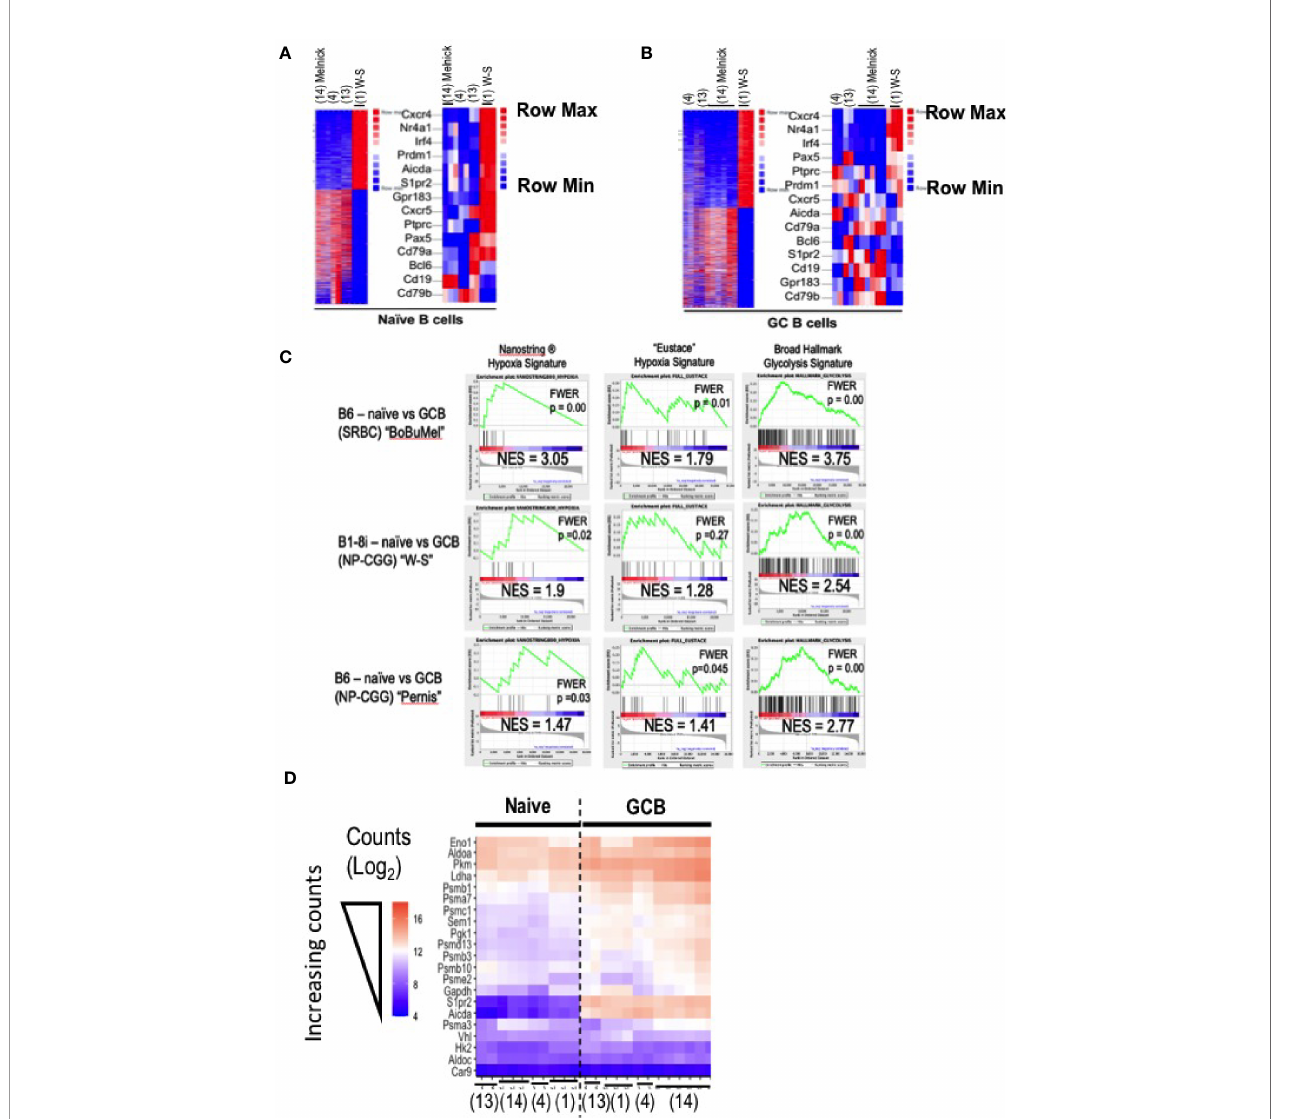
FIGURE 2 | Comparisons of condition-dependent differential gene expression. As in Figure 1 , GEO data deposits were downloaded for the papers cited as (1), “ W- S ” (17);, “ Bu ” (4);, “ Bo ” (18); “ Mel ” and processed by trimming, alignment, generation of normalized counts (FPKM), and quanti fi cation of differential expression using each of two independent pipelines (i.e., both bespoke and Basepair Technologies ’ ). (A, B) Heat maps generated in the Basepair Technologies platform and derived from differential expression analyses comparing the groups “ SRBC-immunized B6 mice ” versus the BALB/c B1-8i, Vk -/- system are shown for (A) naïve and (B) GC B cells. In each panel, all differentially expressed genes (16% and 14% of totals, respectively, i.e., 3214/22,843 and 3461/21,327 genes differentially expressed >2- fold with p-adjusted < 0.05) are displayed. To the right, a subset of B lineage-speci fi c or other genes functionally relevant in GC biology are shown. In these heat maps, entries that are dark red are upregulated and those that are blue are downregulated. Since the rows (genes) are Z-Score scaled, the maps report differences in expression of single genes across the samples. (C) Gene Set Enrichment Analyses (GSEA) were performed using the Broad algorithm as detailed in the Methods log. Analyses were performed both with data derived by the bespoke pipeline (shown here) and with the expression data exported from the Basepair pipeline, which yielded congruent results to those shown here. Inset values show the normalized enrichment score (NES) and p value after compensation for multiple comparisons (FWER), as indicated. Each panel displays results for a separate analysis in which ranked differential expression data were processed using the Broad Institute ’ s GSEA software. The three columns represent outputs obtained using the indicated gene signatures: Hypoxia Signature as established by Nanostring Technologies ® , the hypoxia gene signature of Eustace et al. [as in references (4, 12)], and the Broad Institute ’ s Hallmark Glycolysis gene set. The rows of panels identify the RNA- Seq data sets that were analyzed in comparisons of GC to naïve B cells: (i) data from like samples in (4, 17, 18); (ii) data from (1); and (iii) data from (29), all of which were processed through the same pipeline with same parameters. (D) A heatmap of the blinded variance-stabilizing transformed (VST) count data for selected genes encoding glycolytic enzymes or hypoxia-related genes in all samples [naïve and GC B cells of (1, 4, 17, 18)], benchmarked against two genes ( Aicda ; S1pr2 ) known to be highly expressed in GC B cells. Color coding from lowest (darker purple) counts to highest (deepest peach) is as indicated. Columns position (placement and order) was the computational result of self-organizing mapping, with expected separationi of naïve from GC B cells. Citations below the heat map indicate the publication sourcing of each column ’ s